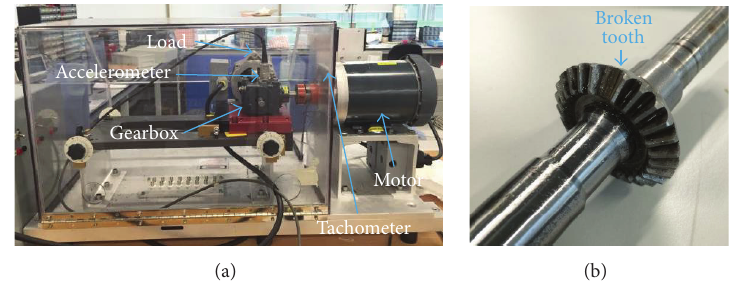
Figure 5: Layout of the test rig: (a) sensor attachment and (b) the faulty gear with a broken tooth.